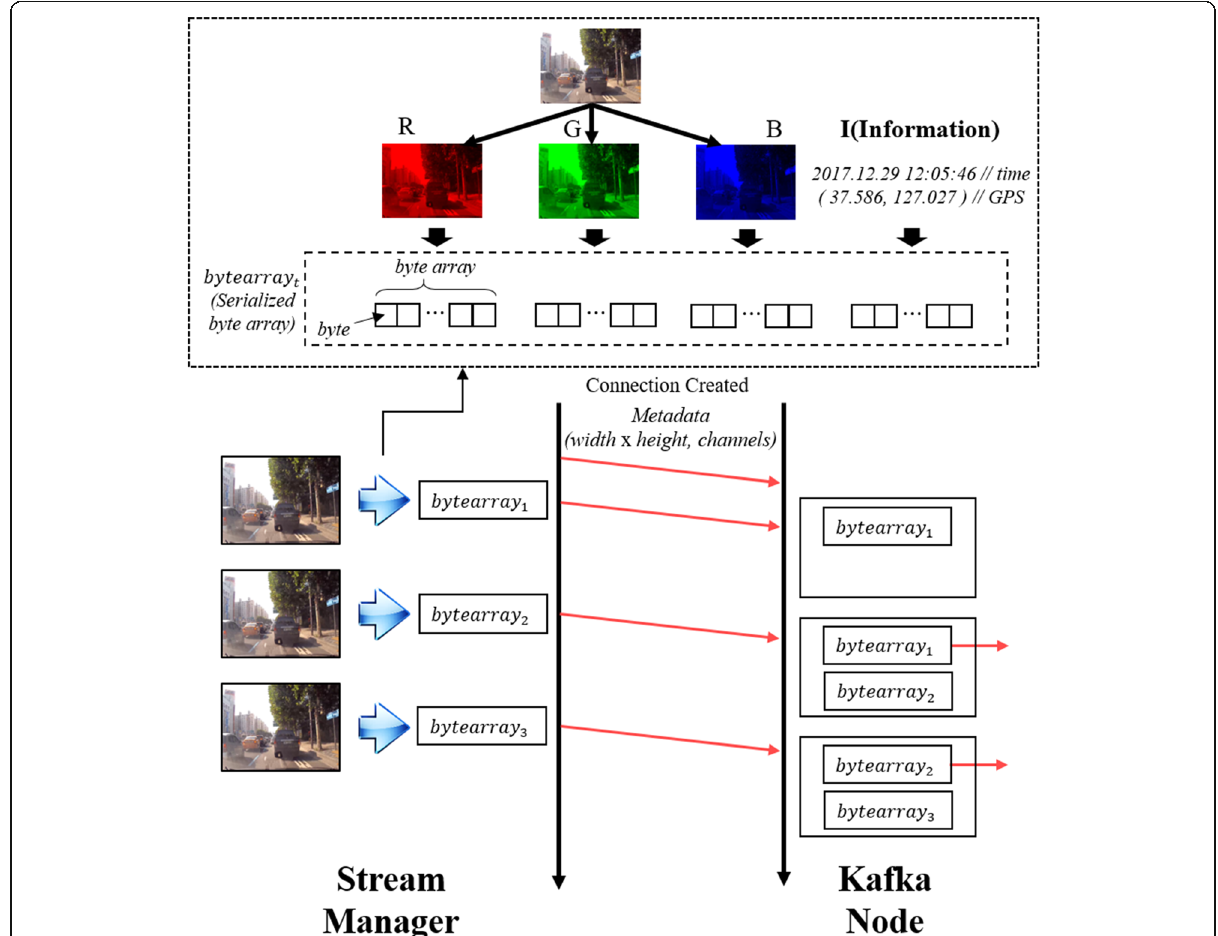
Fig. 2 Transmission steps between Stream Manager and a node in a Kafka